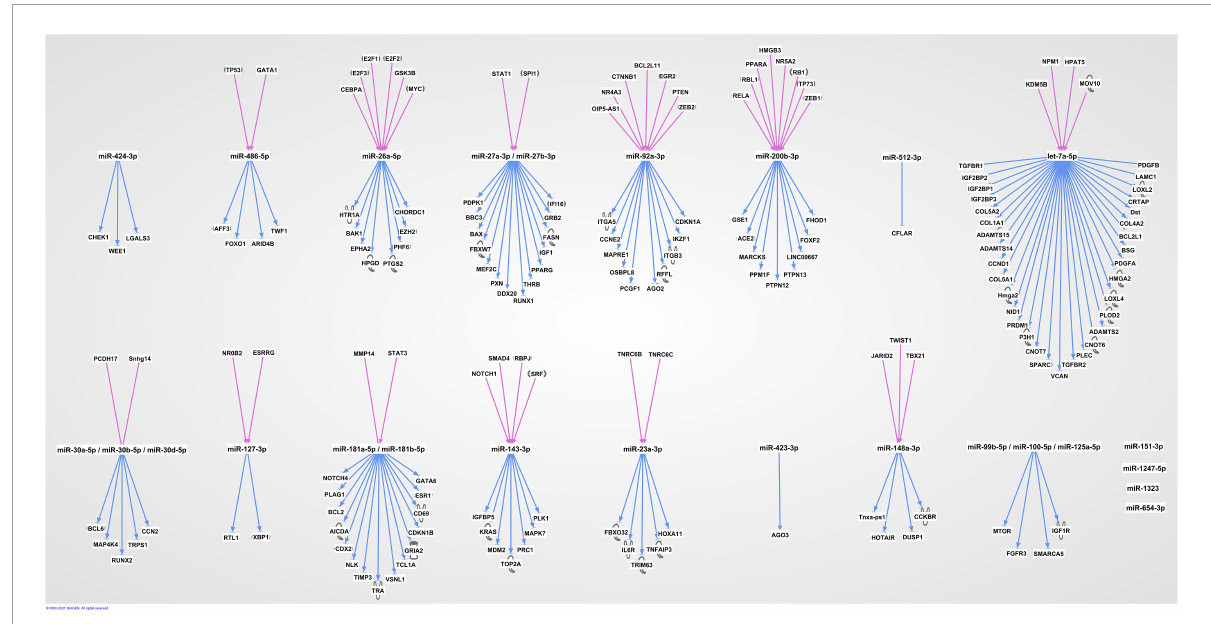
FIGURE1 The 20 most highly expressed miRNAs in human term healthy placentas and their predicted enrichment of associated upstream regulators and downstream molecules in IPA knowledge